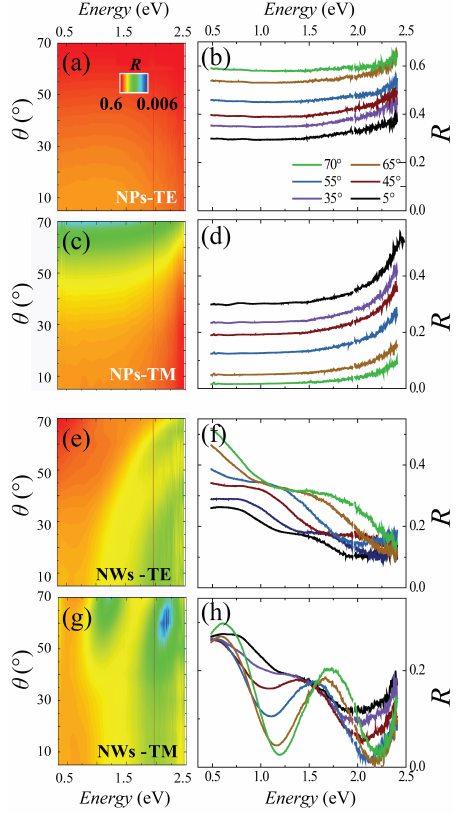
Figure 2. Angle- and energy-resolved reflectance modulations. Logarithmic color plot of the angle- and energy-resolved specular reflectance measured on the InAs substrate with the dispersed Au-rich NPs ( a , c ) and on the InAs NWs ( e , g ). Reflectance spectra measured at different incident photon angle θ (indicated by different color curves) for the Au-rich NPs dispersed on the InAs substrate ( b , d ) and for the InAs NWs ( f , h ). Transverse electric (TE) and magnetic (TM) light polarizations are indicated by labels. Marked reflectance modulations versus photon energy and incidence light angle occur in the InAs NWs, while almost featureless reflectance is observed for the InAs substrate with dispersed Au-rich